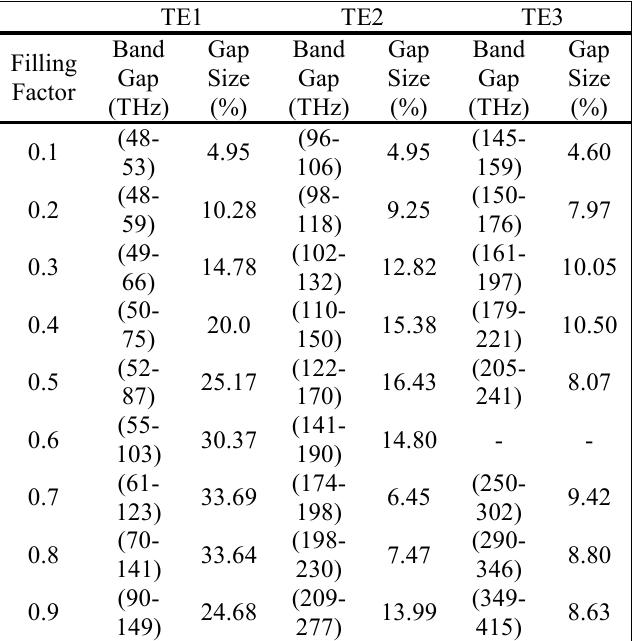
Table 2: Variation of full band gap size for TE modes with filling factor for SbSBr based layers in air